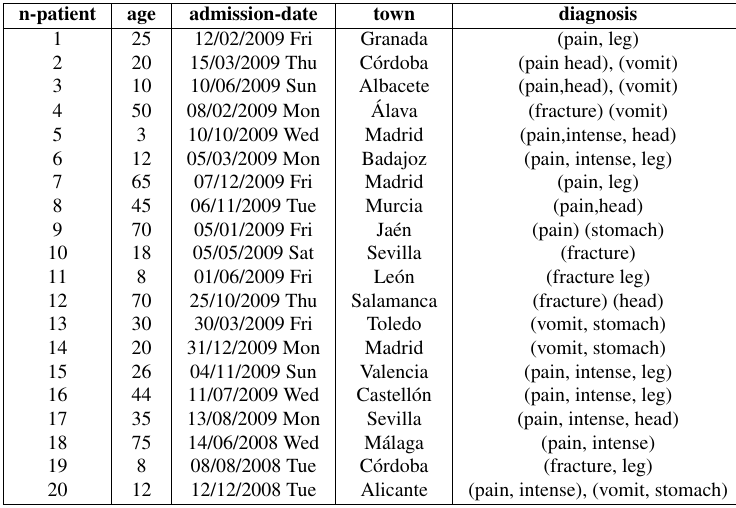
Figure 2: Global AP-Structure